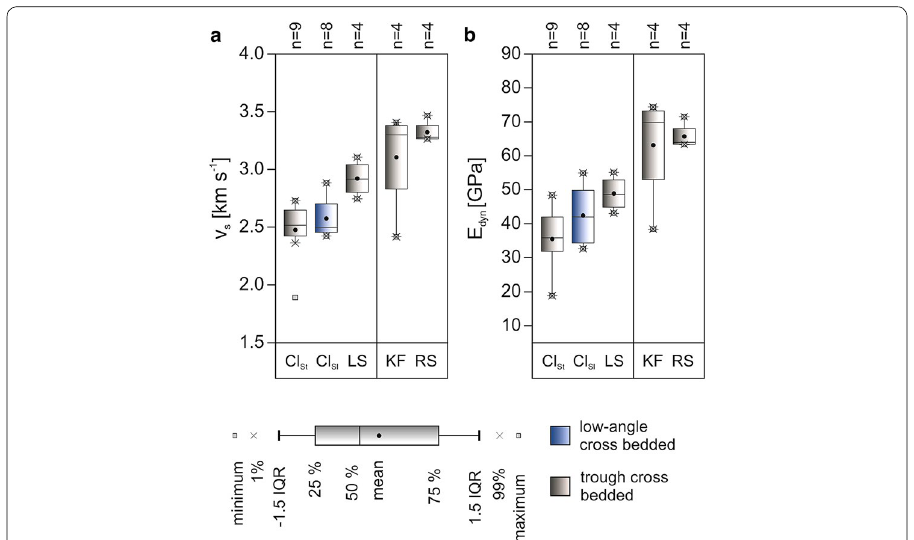
Fig. 5 Box–whisker plots of ( a ) shear‑wave velocities and ( b ) dynamic Young’s moduli ( E dyn ), as calculated from sonic velocities. Outcrops ordered according to their location, from west to east, and colour coded according to fabric